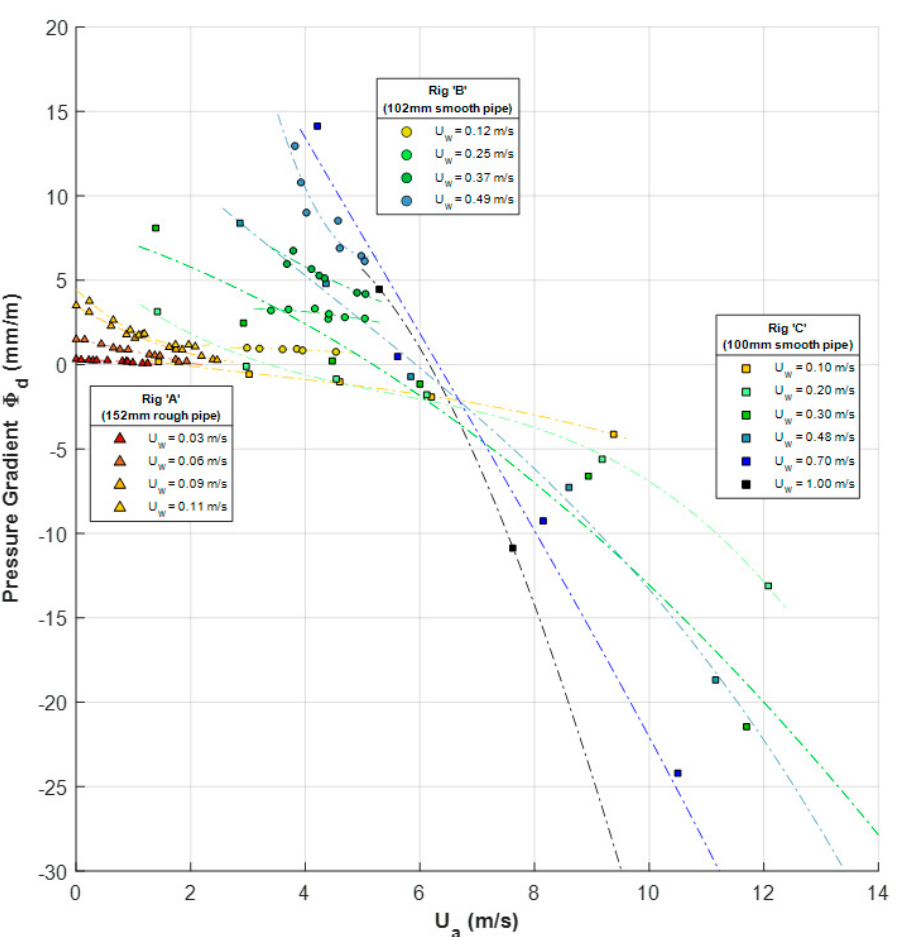
Figure 8. Developed flow pressure gradient components obtained from the Rig ‘A’, Rig ‘B’ and Rig ‘C’ datasets. Table 2. Notes which apply to calculation of the Φ d components shown in Figure 8 using the Rig ‘A’ and Rig ‘C’ datasets.